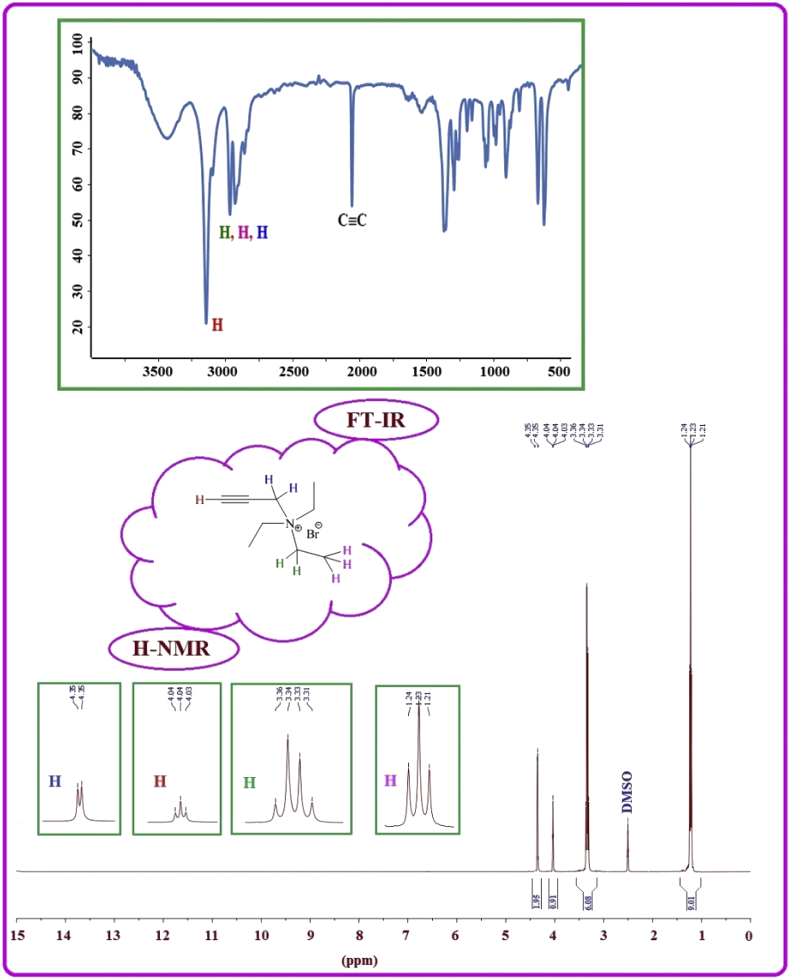
FT-IR and 1H NMR of propargyl triethyl ammonium bromide.